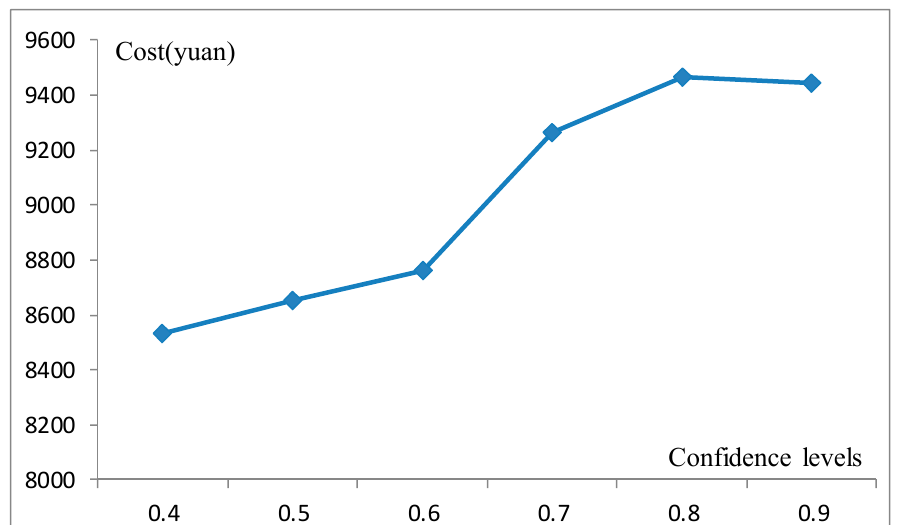
Figure 9. Relationship between confidence level and system cost.